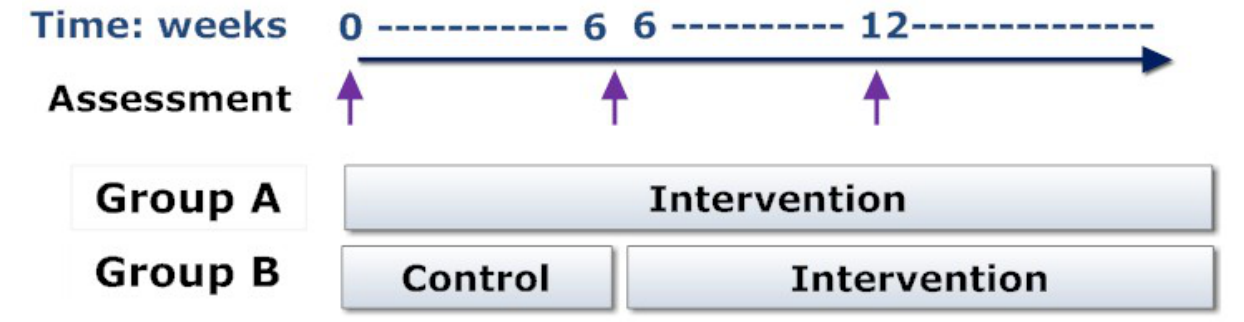
Figure 1. Study intervention and control